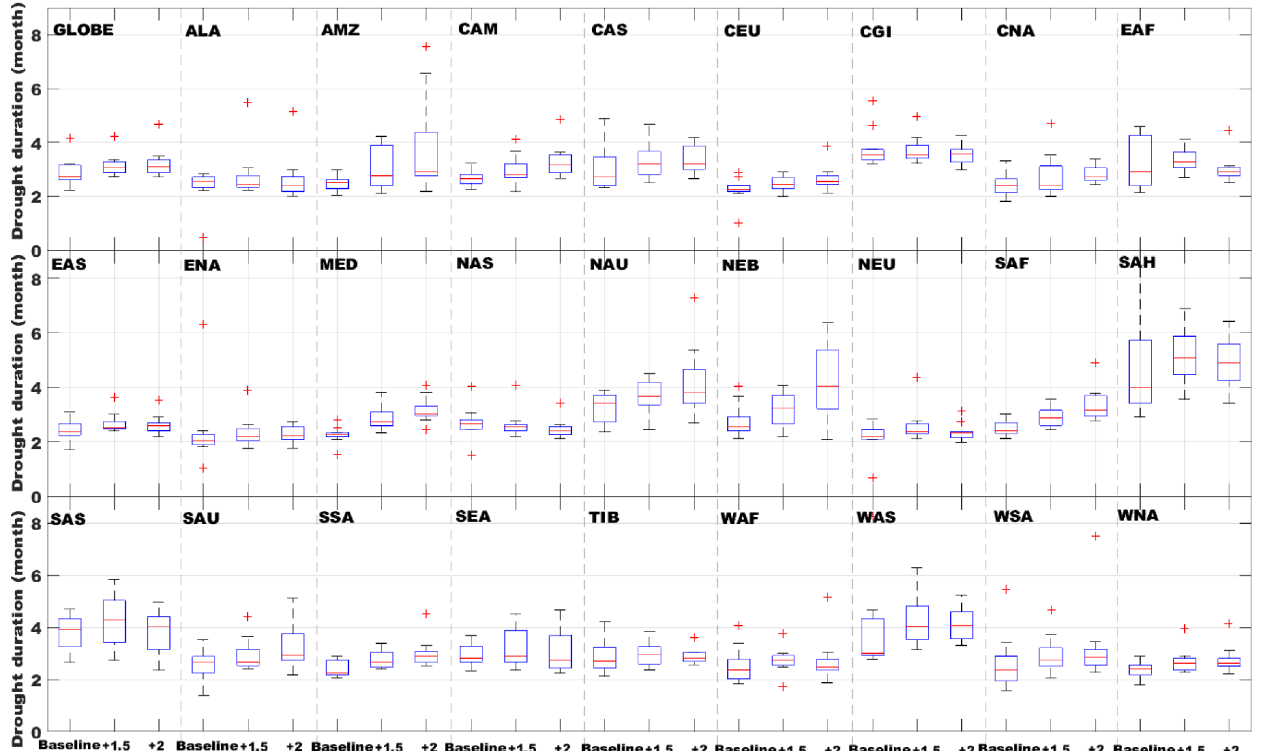
Figure 6. Multi-model projected drought duration (in months) globally (66 ◦ N–66 ◦ S) and in 27 world regions from the baseline period to the 1.5 and 2 ◦ C warmer worlds. The projected uncertainty of multiple climate models is shown through box plots for each region and for each